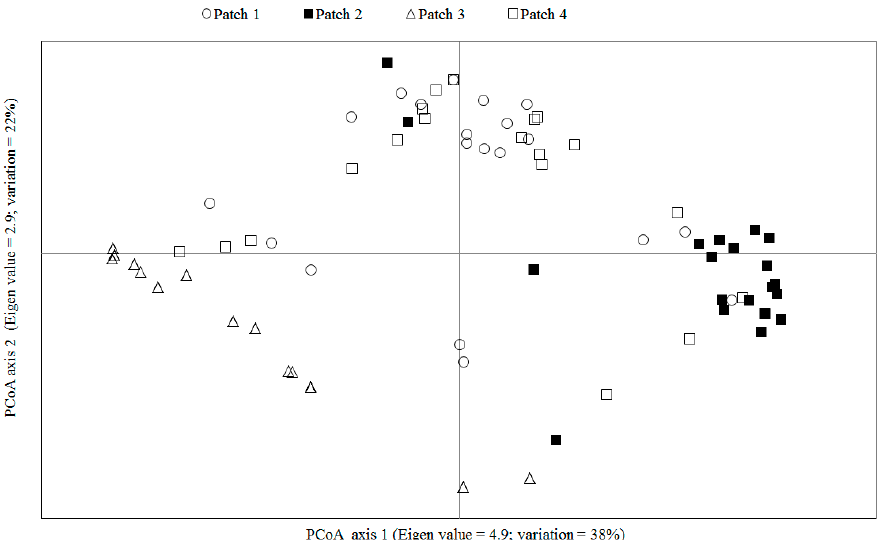
Figure 3. Genetic relatedness revealed by the spatial analysis of Principal Component Analysis. The two first axes added 60% of the variance that determines the spatial distribution among the genotypes.